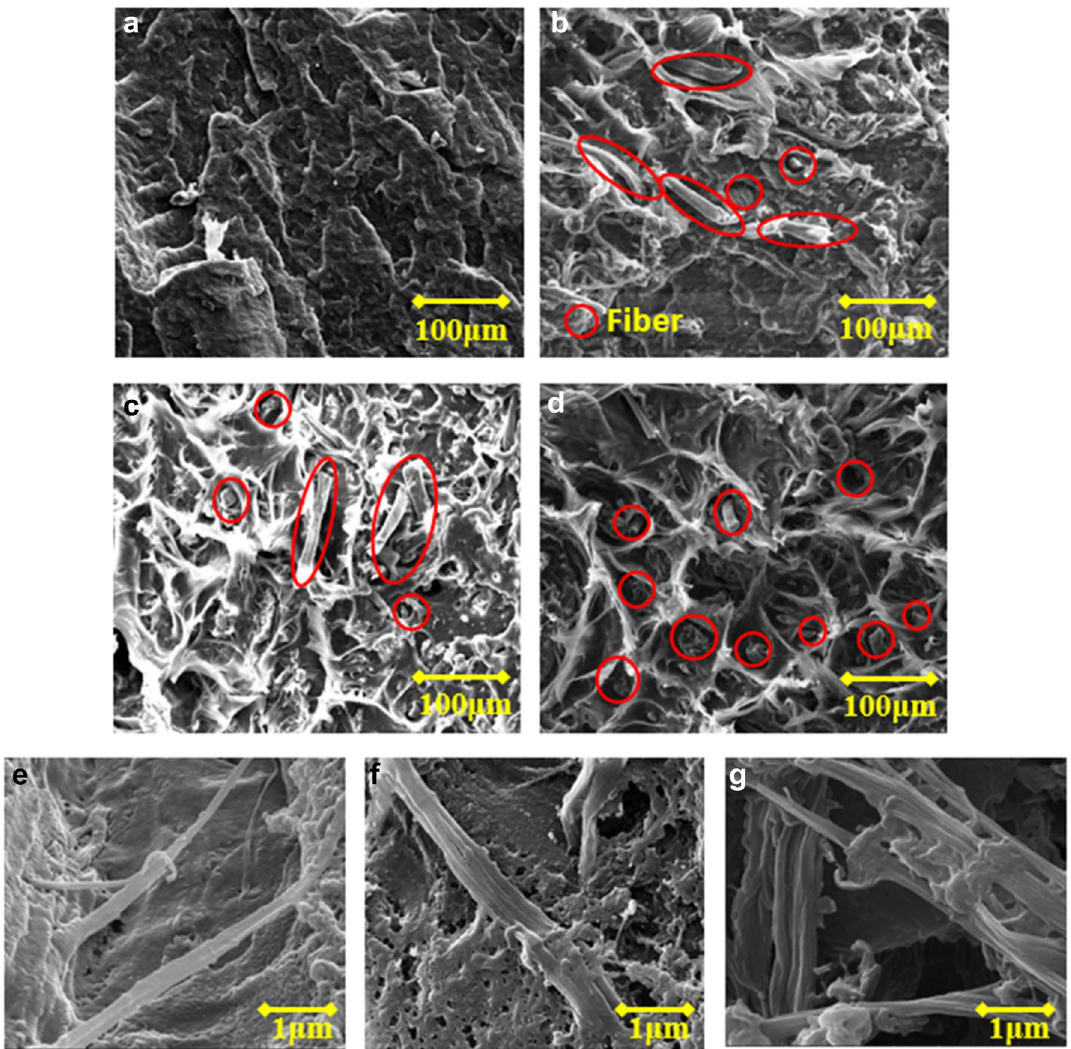
Figure 2. SEM images of tensile fractures of ( a ) neat PP, ( b ) raw cotton/PP, ( c ) ASA-SMC-cotton/PP with one time compounding, ( d ) ASA-SMC-cotton/PP with double compounding, and ( e – g ) cellulose nanofibers in the ASA-SMC-cotton/PP double compounded composites. Broken fibers at the fracture surfaces are circled in ( b – d cotton. Given the same cotton fiber loading, the average tensile strength of the cotton/PP composites increased in the order of neat PP, raw cotton/PP, SMC-cotton/PP, ASA-cotton/PP, and ASA-SMC-cotton/PP. Student’s t-test analysis revealed that all treatments (SMC, ASA, and both) significantly increased tensile strength com- pared to neat PP at a 5% significance level. The differences between neat PP (30.80 MPa) and raw cotton/PP (31.18 MPa) were not significant. This is in line with what has been reported in the literature 23–29 . Due to their different polarities, hydrophilic cotton fibers without a pretreatment could not form strong interfacial bonding with hydrophobic PP matrix, leading to poor reinforcing effect. This is evidenced by the pullout phenomenon in the SEM images of the fractures, where deboned fibers with a bare surface were observed. The raw cotton/ PP and SMC-cotton/PP (31.76 MPa) had comparable strength. ASA-SMC-cotton/PP showed noticeably higher tensile strength (37.34 MPa) than ASA-cotton/PP (32.49 MPa) and SMC-cotton/PP, demonstrating the effect of combining the ASA and SMC treatments. The high strength of ASA-SMC-cotton/PP was consistent with the tensile fractured surface showing less fiber pullout and voids between fibers and the PP matrix. The grafted hydrophobic ASA on fiber surfaces enhanced the interfacial bonding between cotton fibers and the PP matrix. The moduli of all these cotton reinforced composites were enhanced from 1.60 GPa for neat PP to 2.12, 2.09, 2.04, and 2.71 GPa for raw cotton/PP, SMC-cotton/PP, ASA-cotton/PP, and ASA-SMC-cotton/PP, respectively. Similar to the tensile strength, ASA-SMC-cotton had the best reinforcement in modulus as well. The better reinforcing effect of ASA-SMC-cotton was evidenced by not only the tensile fractures, the highest tensile strength and modulus, but also their melt rheology shown in Fig. 4. ASA-SMC-cotton had the highest storage modulus (G ′ ), loss modulus (G ″ ), and complex viscosity (η*) due to the strong interfacial interaction between cotton fibers and the PP matrix 30–34 . The well fibrillated CNFs and their interconnected network (as